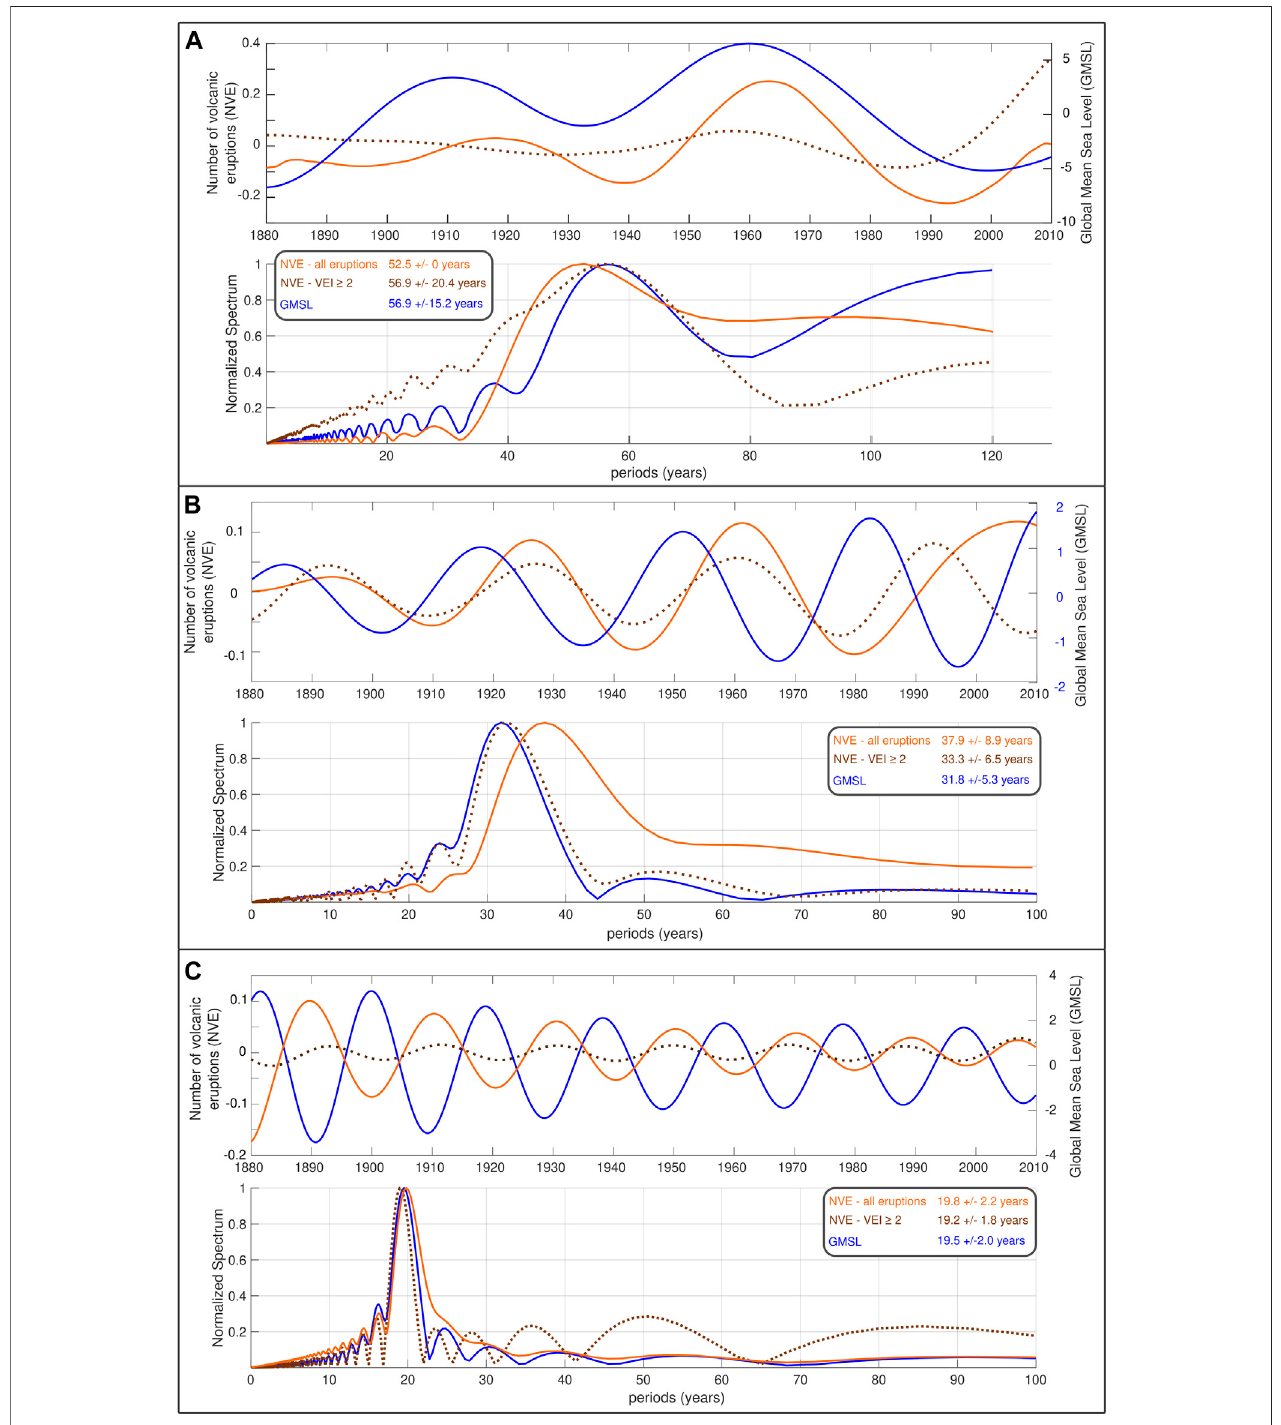
FIGURE 2 | Examples of common long-period components extracted using SSA in the global mean sea level (blue) and volcanism (orange for all eruptions and dotted brown for VEI ≥ 2 eruptions) with that of (A) ~50 – 60, (B) ~30, and (C) ~20 years.